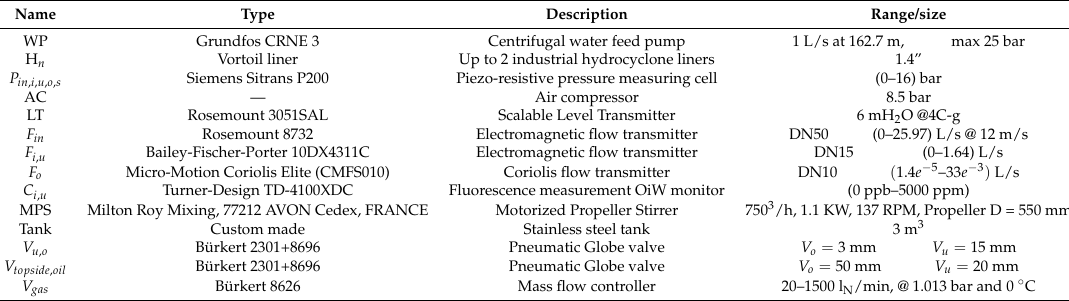
Table 1. Description of the instruments and equipment used for the de-oiling set-up.